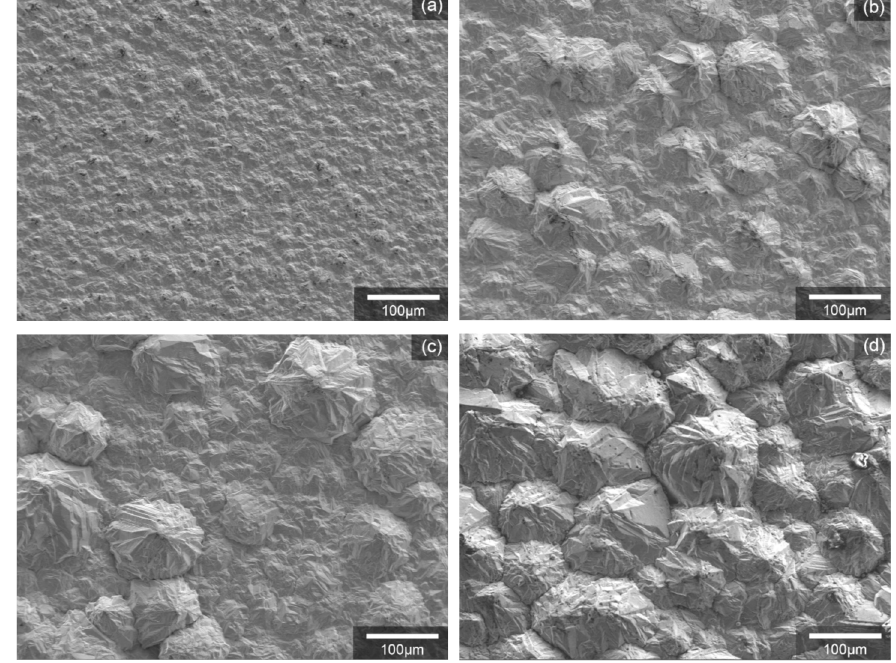
Figure 4. Surface morphology of cathode copper for different electrolysis times in the conventional inlet mode: ( a ) 1 h; ( b ) 3 h; ( c ) 4 h; ( d ) 5 h. The SEM (Scanning Electron Microscope) sampling was at the No. iii position of the cathode copper as shown in Figure 2 and the electrolyte circulation rate was 1.0 L · min − 1